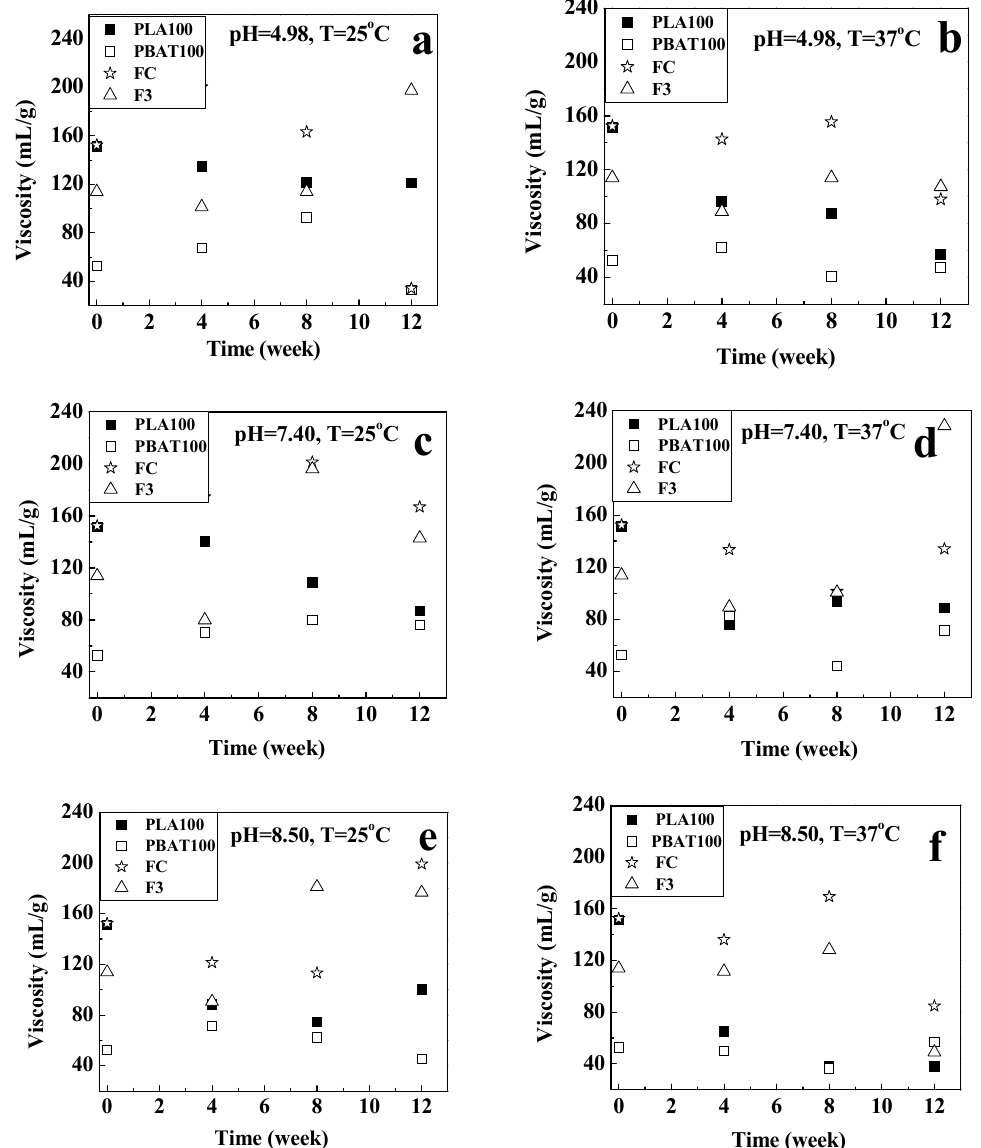
Figure 10. Variation in the viscosity for the fibers for: pH = 4.98 at ( a ) T = 25 °C and ( b ) T = 37 °C; pH = 7.40 at ( c ) T = 25 °C and ( d ) T = 37 °C; and pH = 8.50 at ( e ) T = 25 °C and ( f ) T = 37 °C.